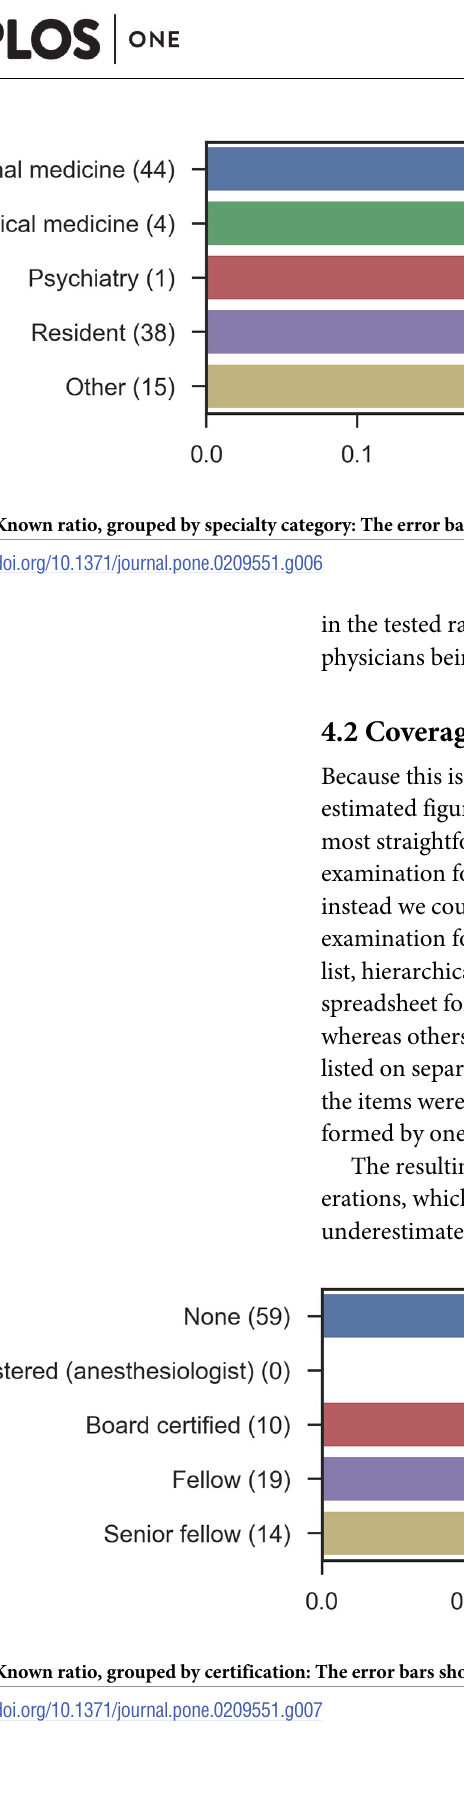
PLOS ONE | https://doi.org/10.1371/journal.pone.0209551 December27,